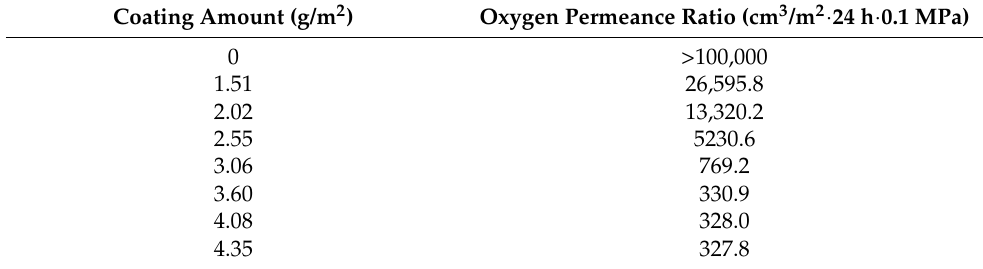
Table 6. Oxygen permeability with different coating amounts on packaging base paper.